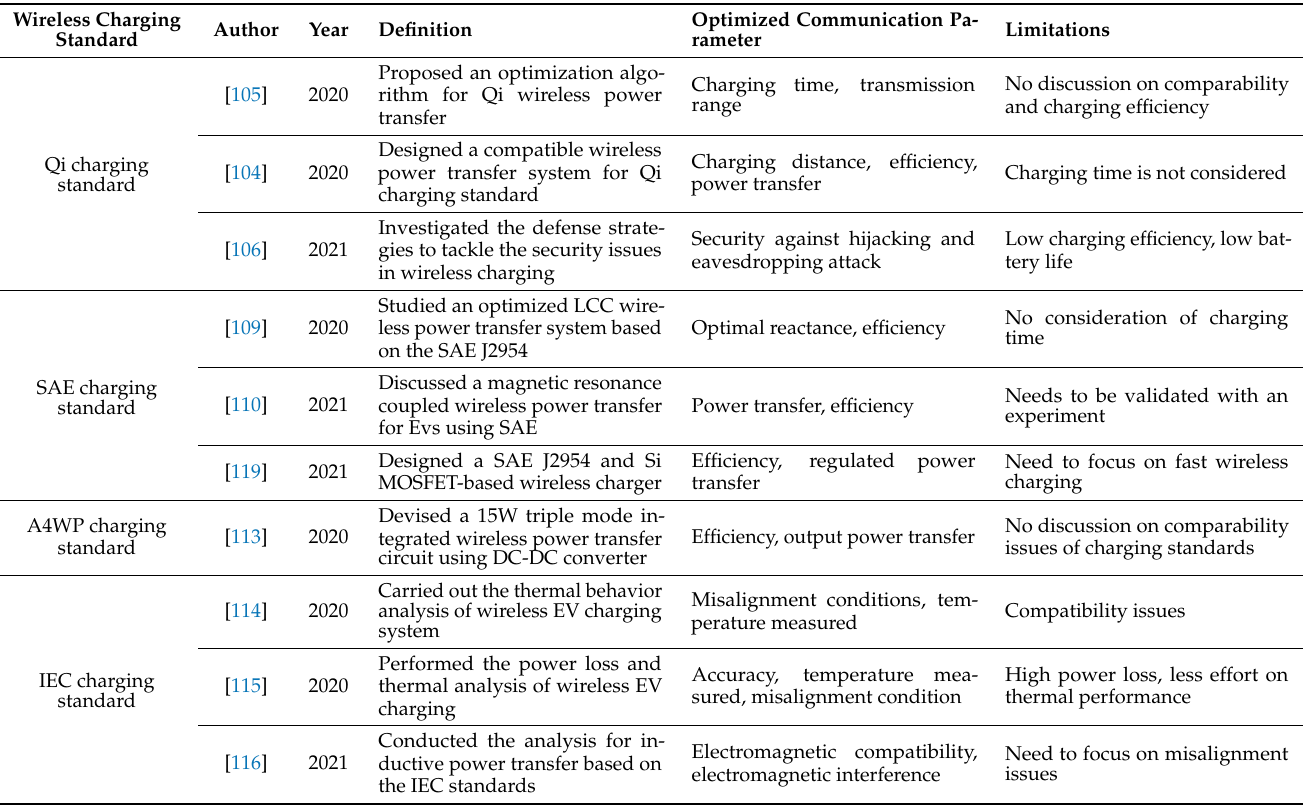
Table 6. Comparison of wireless charging standards based on the different communication parameters.